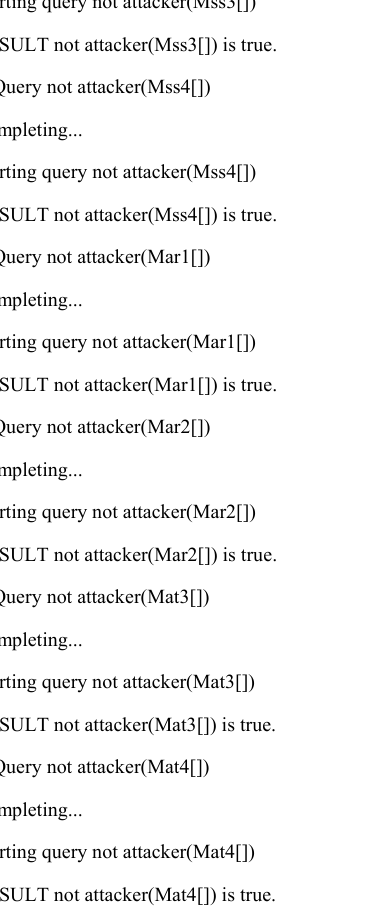
Figure A2. Verification results of correspondence assertion.